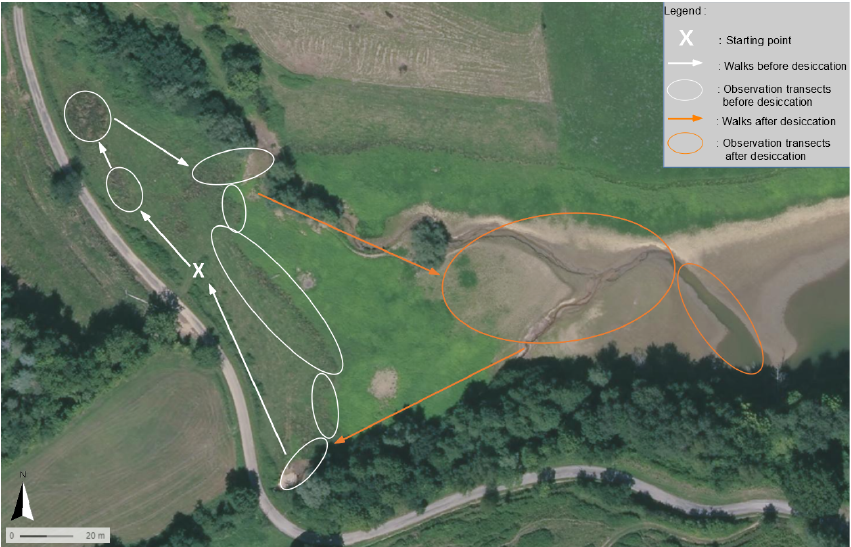
Figure 4. Map of the location of the Pollard walks in the study site. Transects are following the course of the water retreat during summer. White and orange traits indicate transect walked during the flood or the desiccation of the creek,